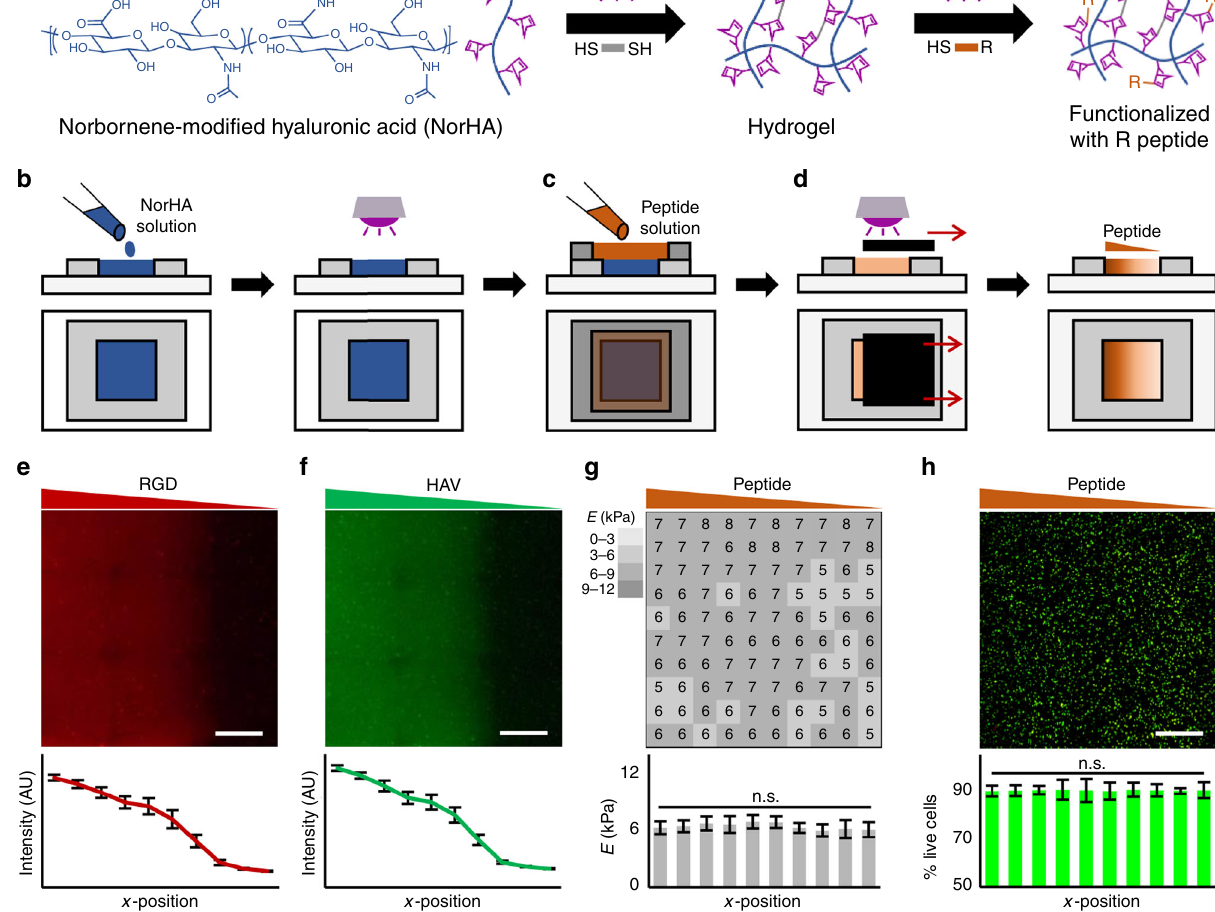
Fig. 1 Scheme for fabricating NorHA hydrogels with single peptide gradients and characterization. a Multi-step thiol-norbornene UV light-mediated reaction between norbornene-modi fi ed hyaluronic acid (NorHA) and di-thiols (DTT) to form a hydrogel and then to subsequently modify with mono- thiolated peptides. Schematic of fabrication process where, b NorHA hydrogels were fi rst formed on 5 × 5 × 0.5 mm 3 molds with UV light exposure, c incubated with 5 mM mono-thiolated peptide solution, and d peptide gradients introduced with an opaque sliding mask to control the extent of light- mediated reaction between peptides and norbornenes in the hydrogel. Images and quanti fi cation of signal intensity of e rhodamine-labeled RGD (GCGYGRGDSPG) or f fl uorescein-labeled HAV (HAVDIGGGC) peptide gradients. g Atomic force microscopy (AFM) of the peptide-modi fi ed hydrogel presented as a heat map and quanti fi cation across the x -position ( n = 10 measurements per zone). h Images and quanti fi cation of mesenchymal stem cell (MSC) viability within NorHA hydrogels with peptide gradient (RGD shown) ( n > 1000 cells per zone). Error bars represent standard error around the mean (s.e.m.); scale bars: 1 mm; n.s., no signi fi cance between